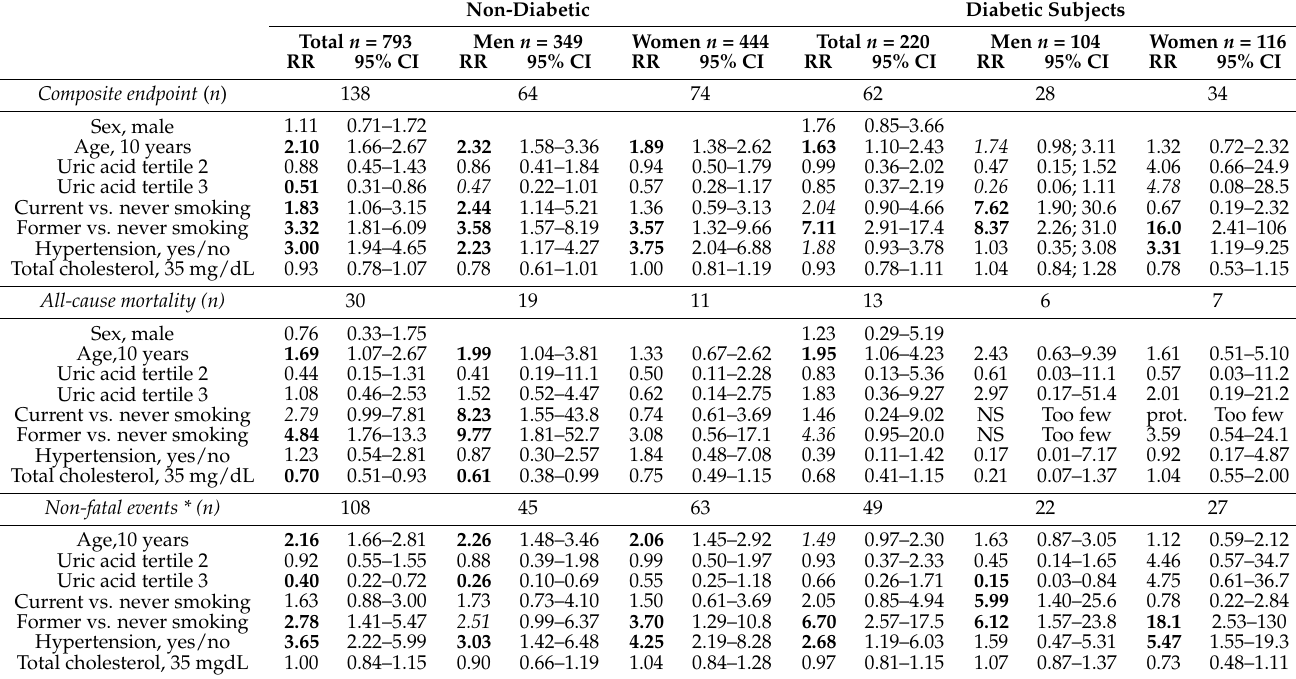
Table 3. Logistic regression analysis of serum uric acid tertiles for outcomes, by diabetic status and gender ( n =1013). RR, relative risk; CI, confidence